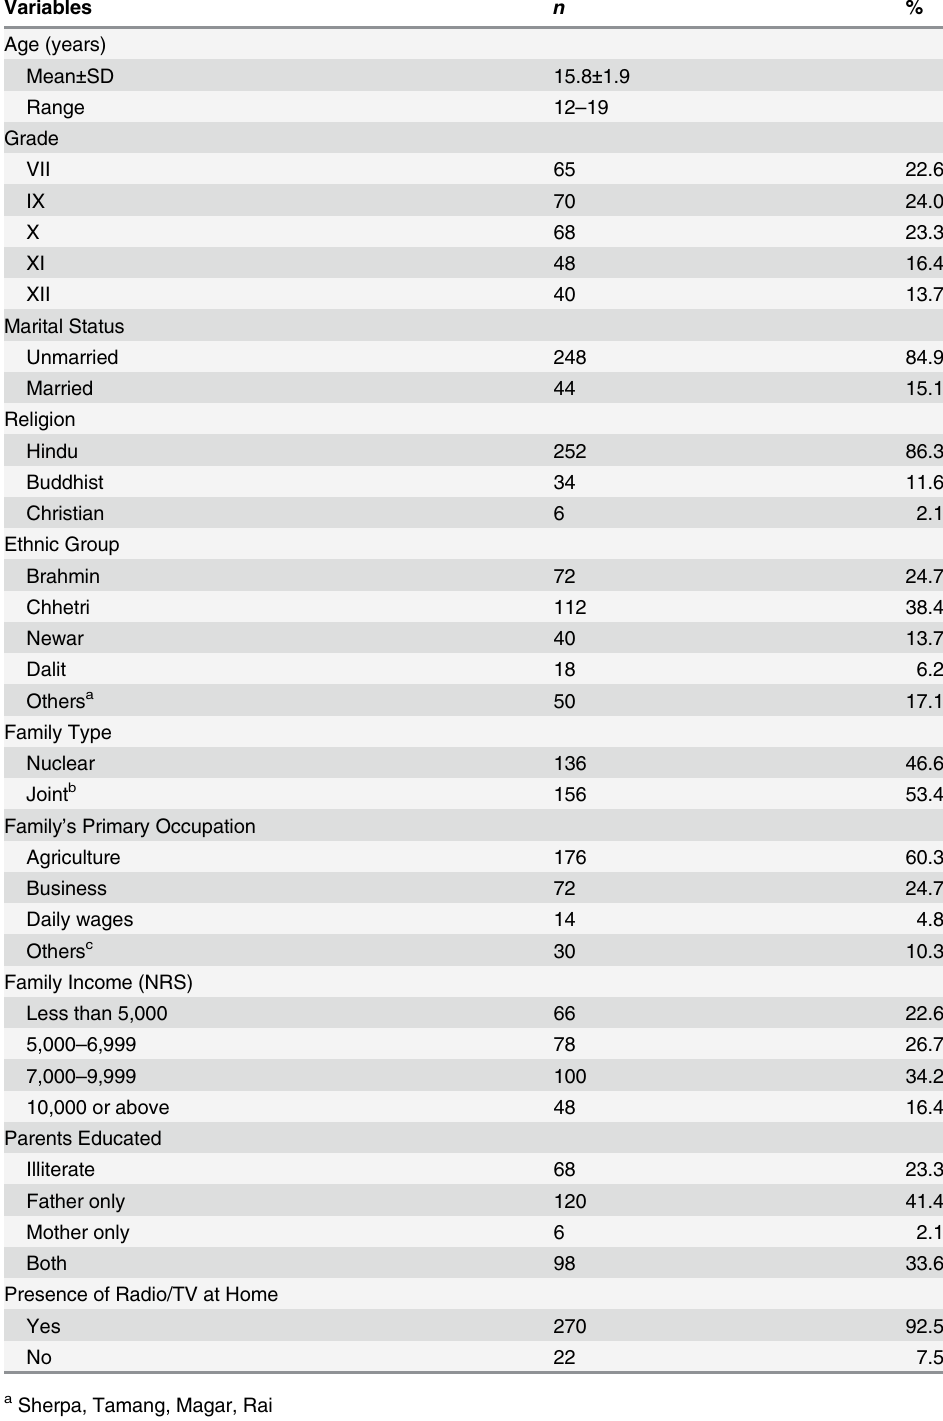
Table 1. Sociodemographic characteristics of the respondents ( n = 292